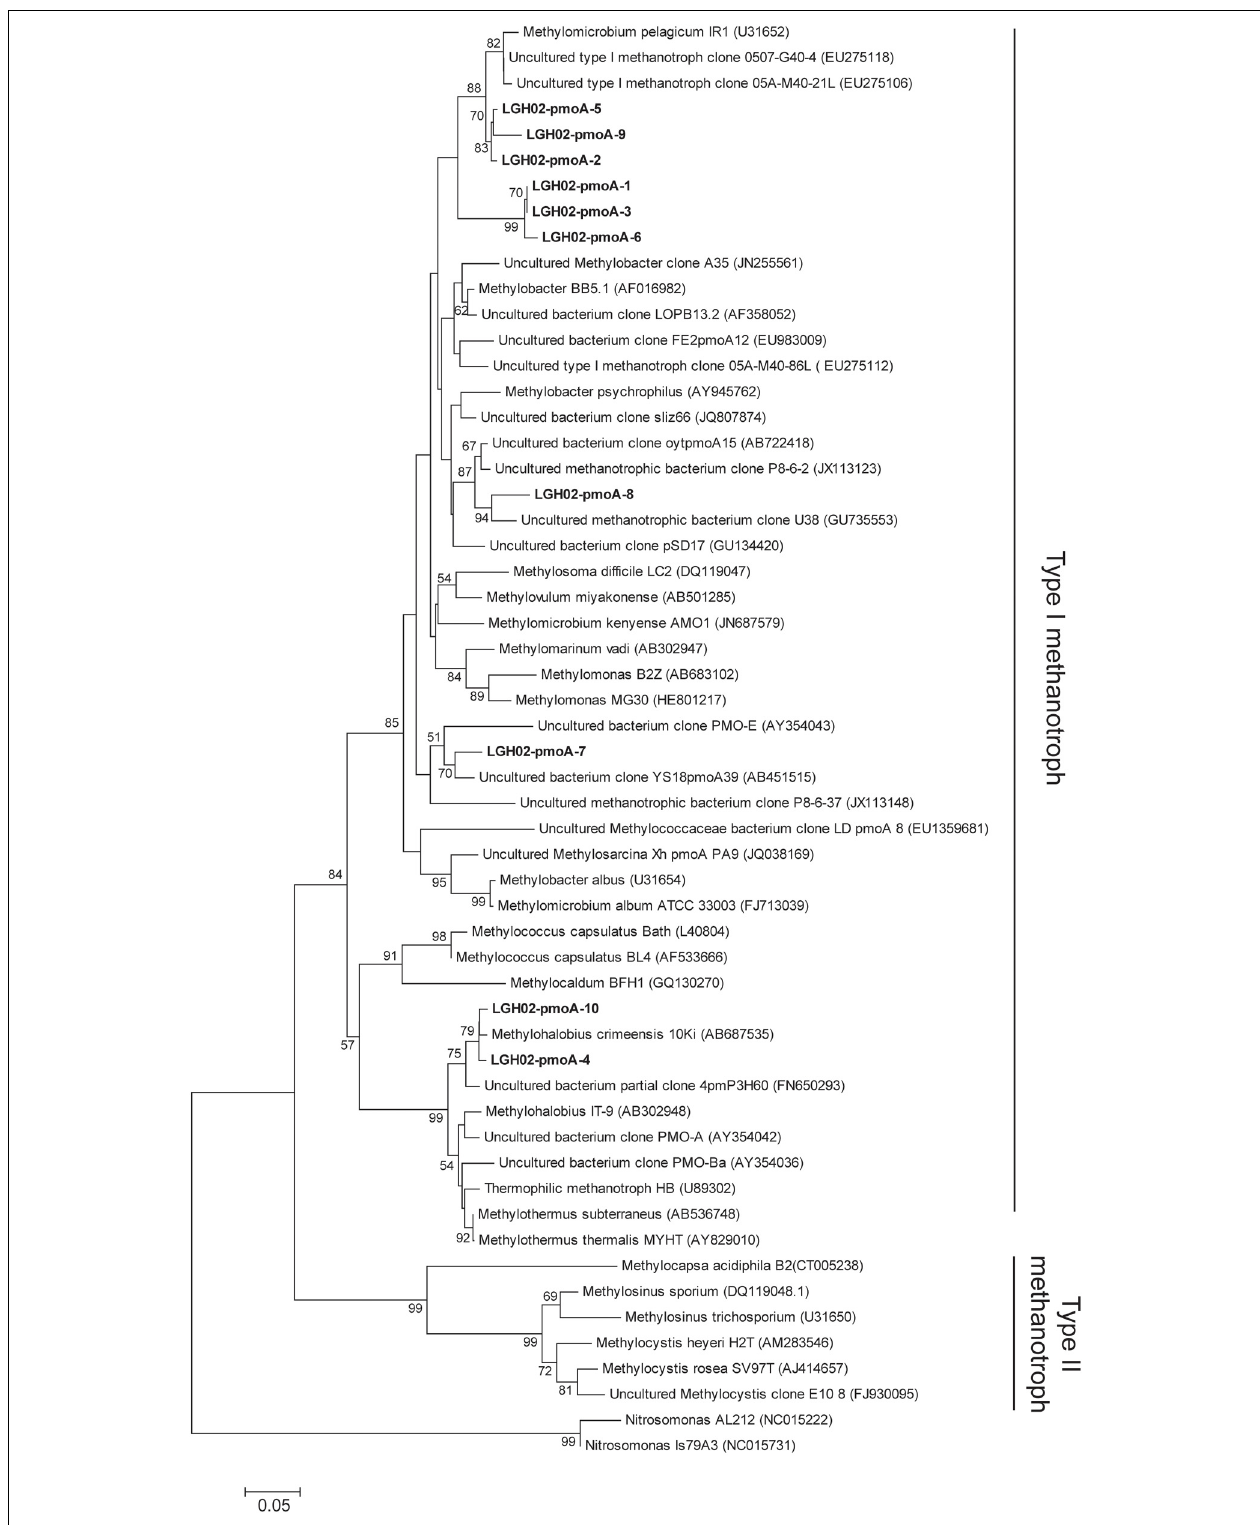
FIGURE 5 | Phylogenetic tree based on the deduced partial amino acid sequences of pmoA genes. The tree was constructed on the basis of ∼ 152 amino acids. Sequences obtained from this study (in boldface) were